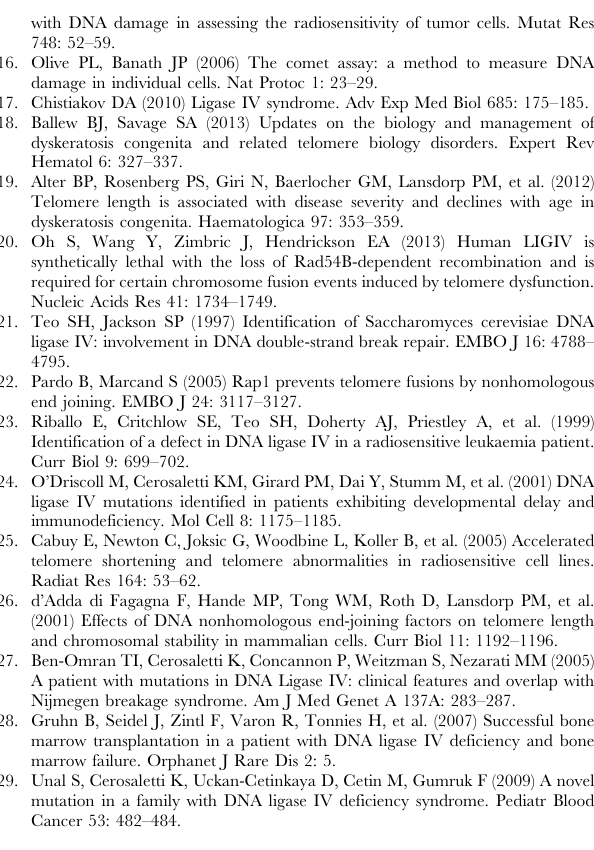
Table S1 List of primers for Sanger sequencing of LIG4 . Table S2 Determination of cis and trans status of LIG4 variants in Patients 1 and 2. Table S3 Variants identified by exome sequencing of Patient 3 (and parents). Table S4 Variants in deletion of chromosome 17q24.3 in Patient 3, as identified by exome sequencing. Table S5 Literature review of patients with LIG4